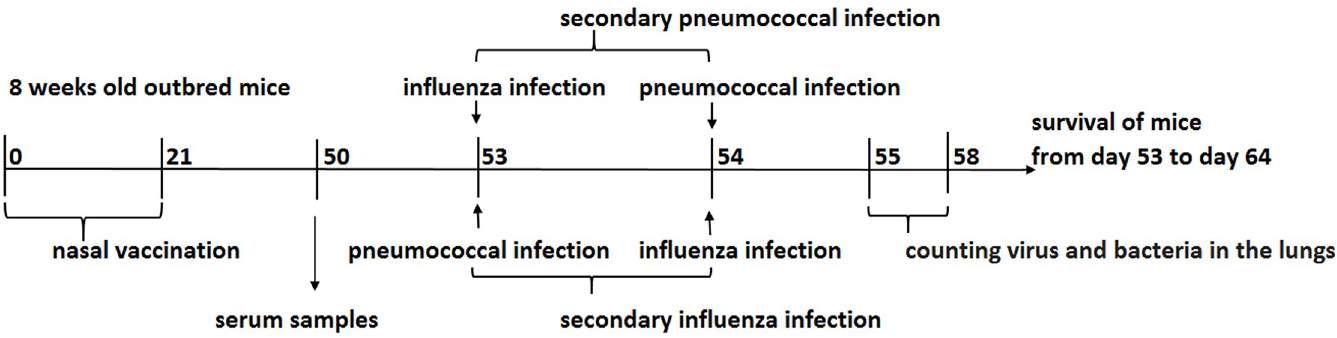
Fig 1. Immunization of mice and analysis of the protective efficacy of combined vaccination. General